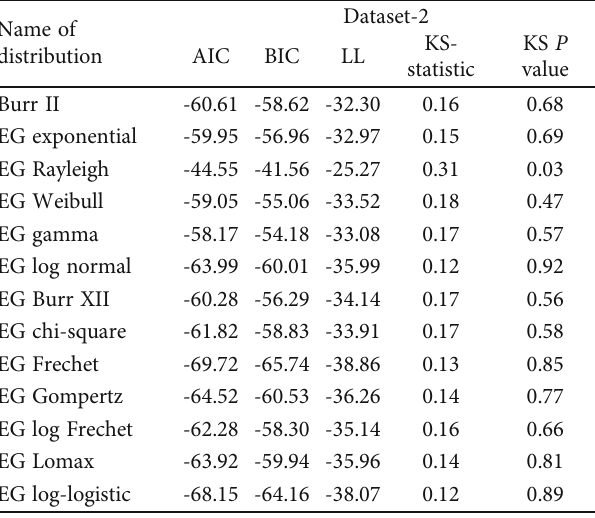
Table 22: Comparison of BT-IID with class of EGGDs using dataset-2.